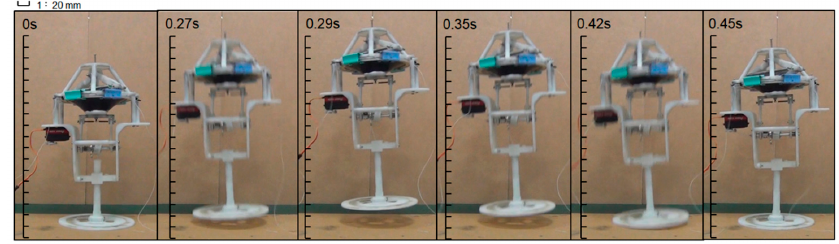
Figure 15. The jumping process of the jumping robot.